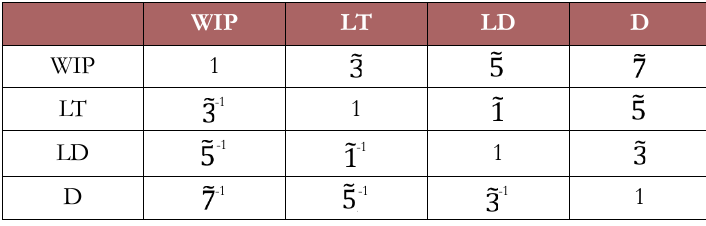
Table 4. Fuzzy comparison matrix of the criteria using triangular fuzzy numbers